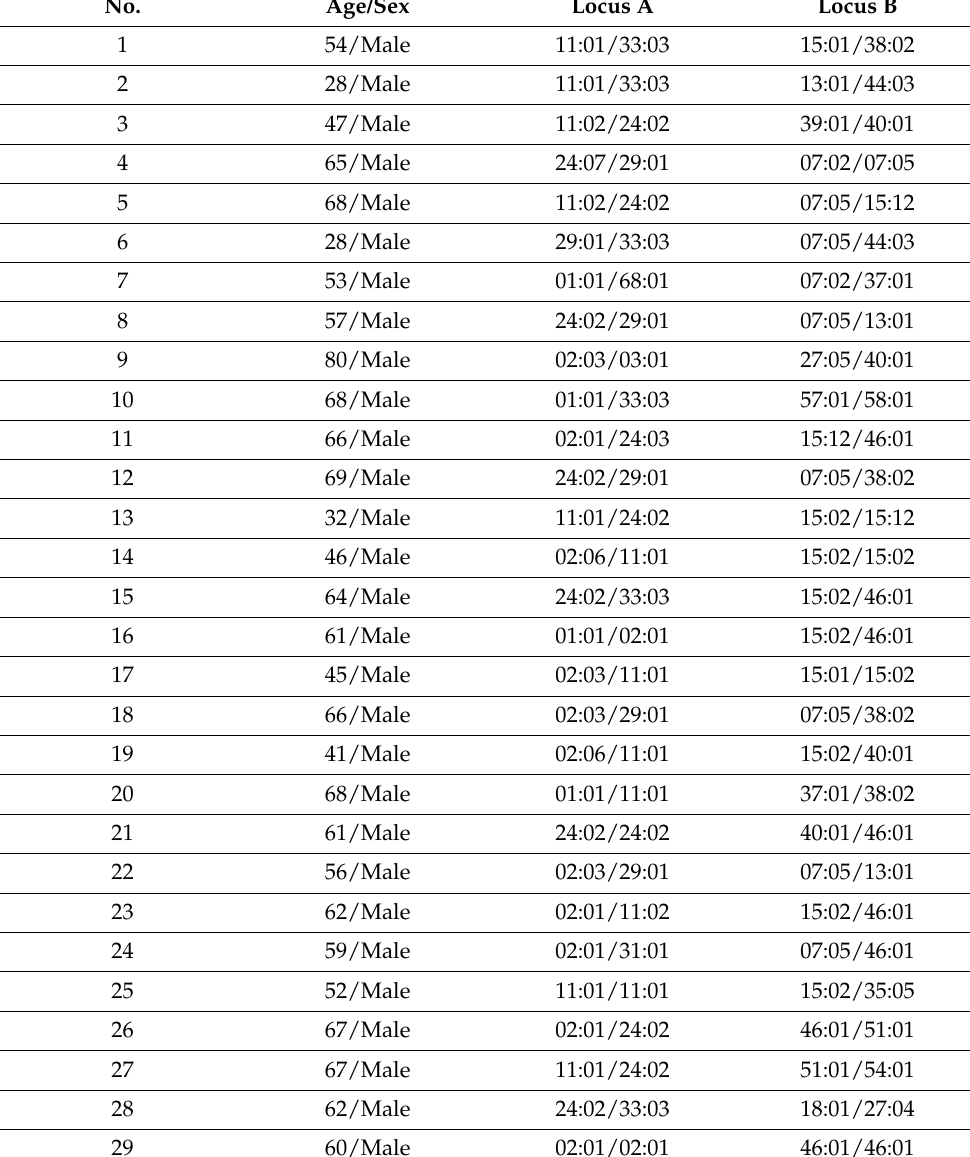
which highly frequent HLA alleles were found in the patients with ALP-induced MCARs but were rarely found in ALP-tolerant patients, and are highlighted in bold italic. Table 3. ALP-tolerant patients with gout, with the corresponding genotypes of HLA alleles. No. Age/Sex Locus A Locus B